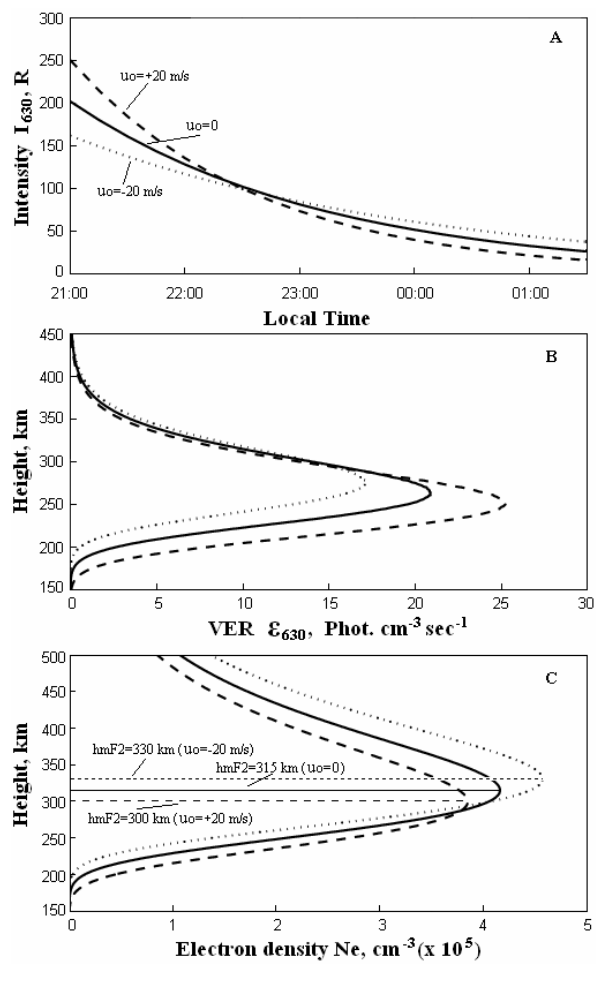
Fig. 3. Night variations of the red line total nightglow intensity I 630 (t) (panel a ), height profile of the VER ε 630 (h) (panel b ) and electron density N e (h,t = t 0 ) (panel c ) for meridional velocity u 0 =− 20m/s (dotted line), u 0 = 0 (full line) and u 0 = 20m/s (dashed